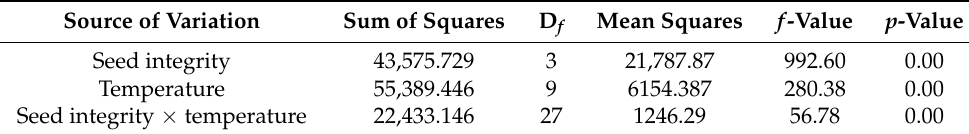
Figure 3. Germination process of the scarified seeds, half seeds, and intact seeds. Germination was performed at a constant temperature of 10 °C with a 12 h light/12 h dark cycle and PPDF = 121 μ mol·m − 1 ·s − 1 . Each treatment had four replicates and 30 seeds were used for each replicate. There are no significant differences between the data labeled with the same lower case letters ( p = 0.05).